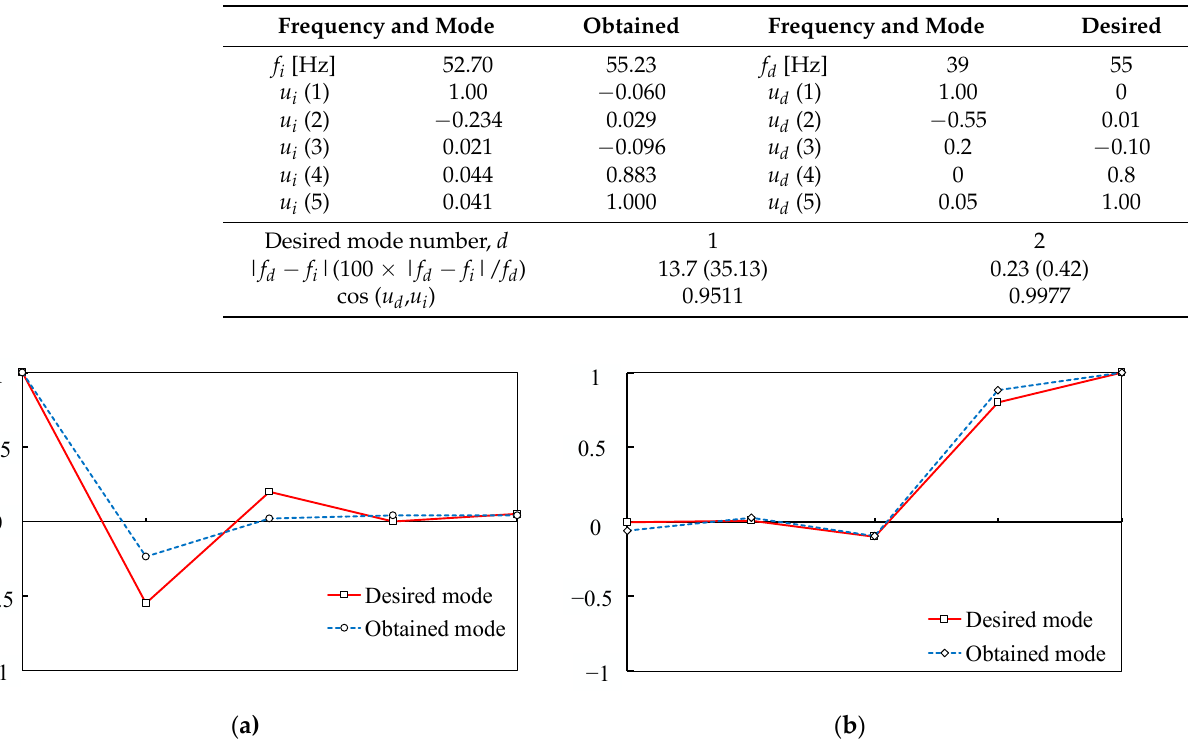
Figure 27. Comparison of desired and attained modes: ( a ) 39 Hz; ( b ) 55 Hz. Table 18. Comparison of natural frequencies and mode shapes.